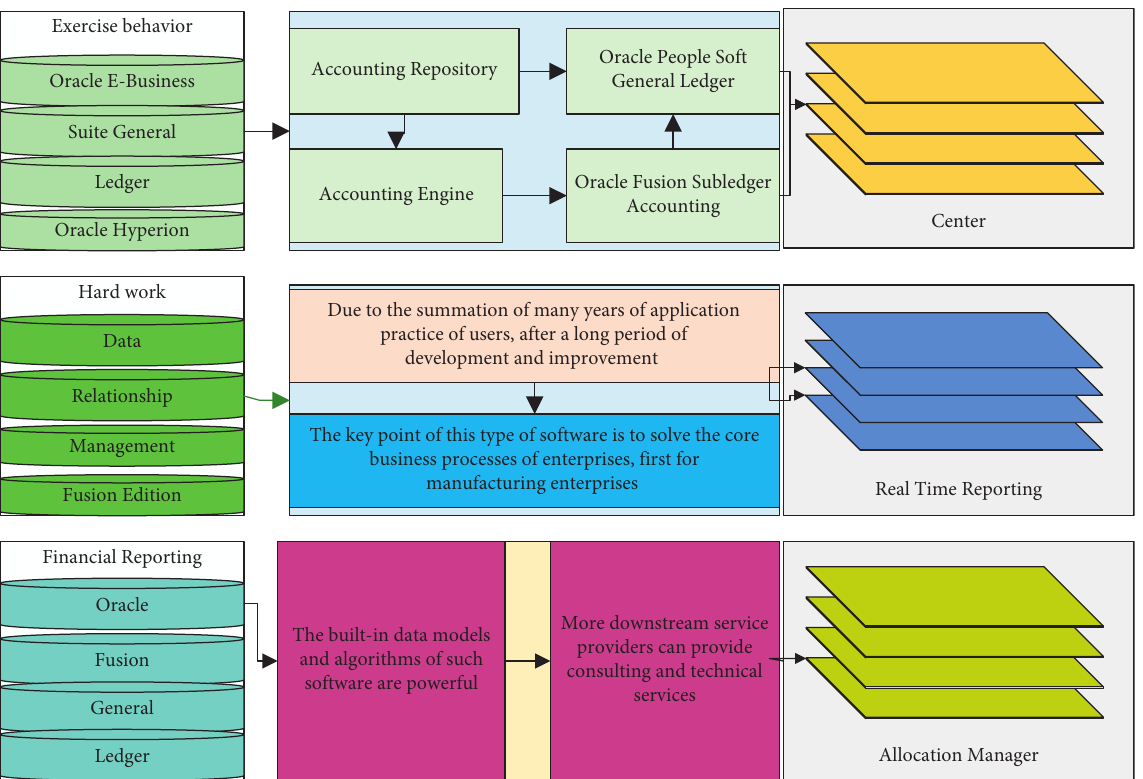
Figure 1: Framework for financial management and decision-making system for big